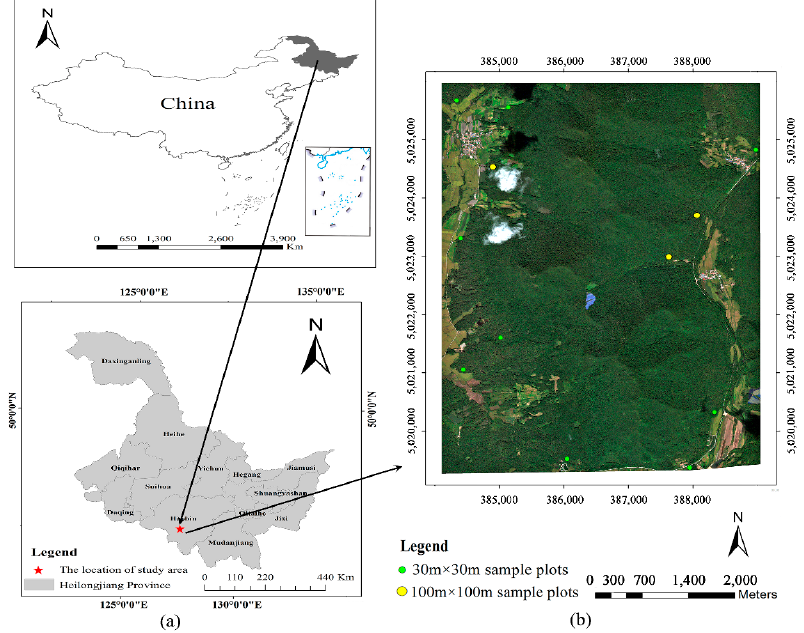
Figure 2. ( a ) The location of Heilongjiang province and Maoershan Experimental Forest Farm. ( b ) The location of sample plots (30 m × 30 m and 100 m × 100 m) within Maoershan over a visible band WorldView-3 image composite.